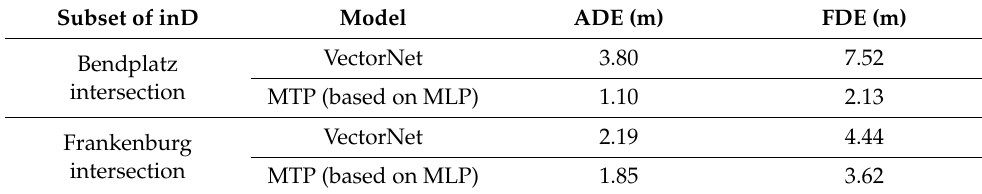
Table 8. Performance of vehicle trajectory prediction models on the inD dataset reported in [42]. Subset of inD